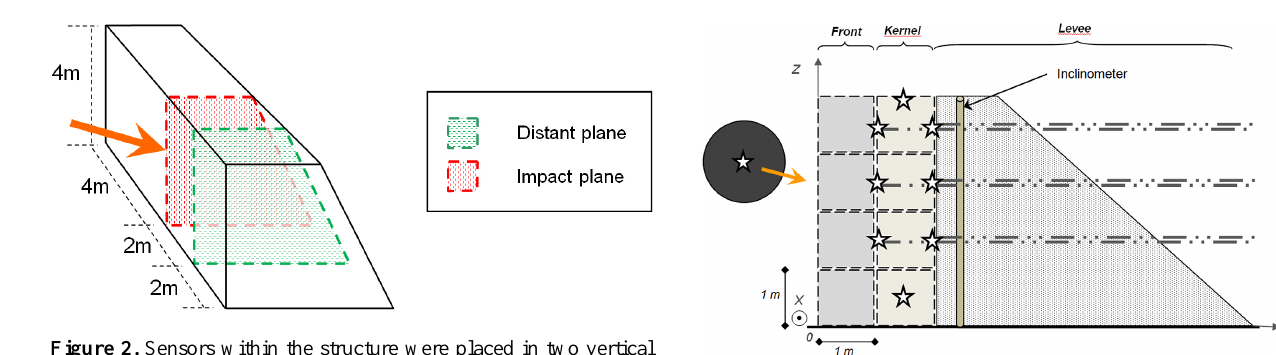
Figure 2. Sensors within the structure were placed in two vertical planes: in the impact direction and 2m aside.